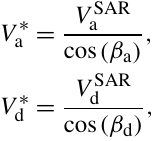
technique is that only the radial component of the velocity is retrieved. To deal with this limitation, the total current velocities are estimated by using the direction given by the altimeter-derived geostrophic currents, whose norm is cor- rected using a radial component measured by the SAR from either the ascending or descending passes. The